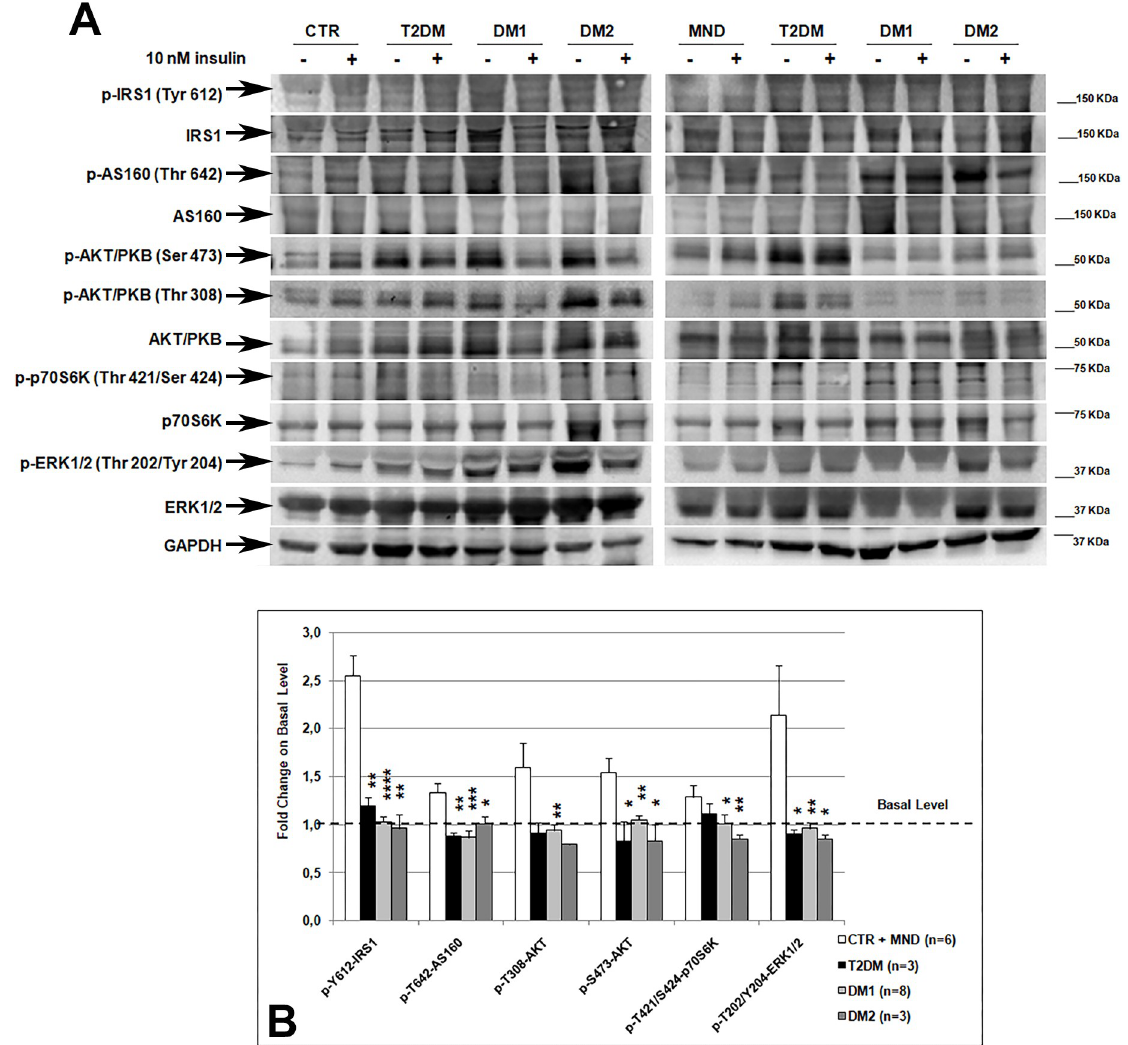
Fig 3. Insulin signalling activation in skeletal muscle biopsies. (A) Representative western blot analysis of the expression and phosphorylation of proteins involved in the insulin pathway. Skeletal muscle samples were incubated in absence (-) or presence (+) of 10 nM insulin for 20 minutes. Due to the high number of samples analysed, the figure panel is composed by images of two different gels. Details on how western blot experiments were performed are reported in Materials and Methods. (B) Fold change on basal level of the quantification of IRS1, AS160, AKT/PKB, p70S6K and ERK1/2 activation. Histograms represent mean values and bars represent standard error of the mean (SEM). The number of samples analysed in each group is reported in graphic legend. Differences between groups have been evaluated by Student t -test. � p < 0.05; �� p < 0.01; ���� p < 0.0001.